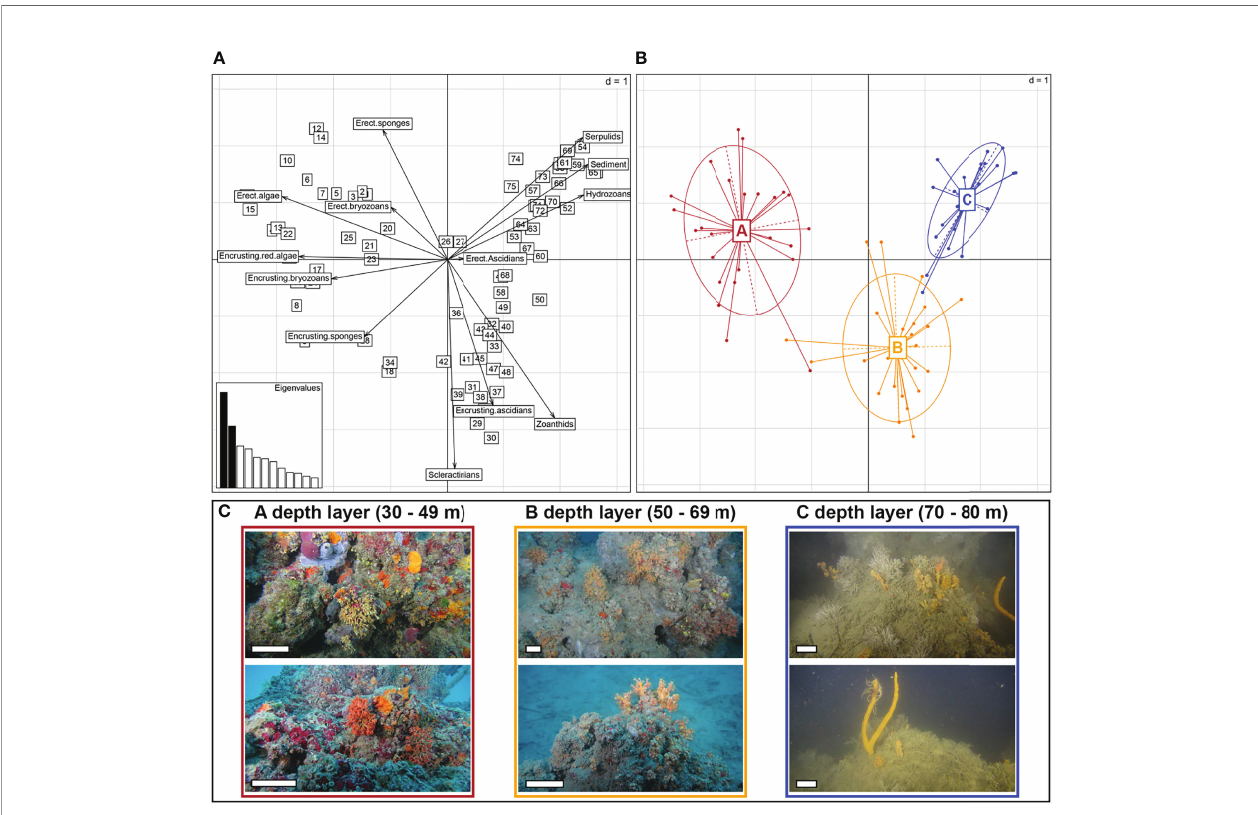
FIGURE 3 | Results of the Principal Component Analysis (PCA) carried out on the structure of the assemblages colonizing outcrops over the study area: (A) Biplot showing sampling points and taxonomical units (solid lines with arrows); (B) sampling points grouped according to depth layers; (C) Pictures acquired during ROV preliminary surveys showing the outcrop assemblages in each of the three depth layers (scale bars refer to 10